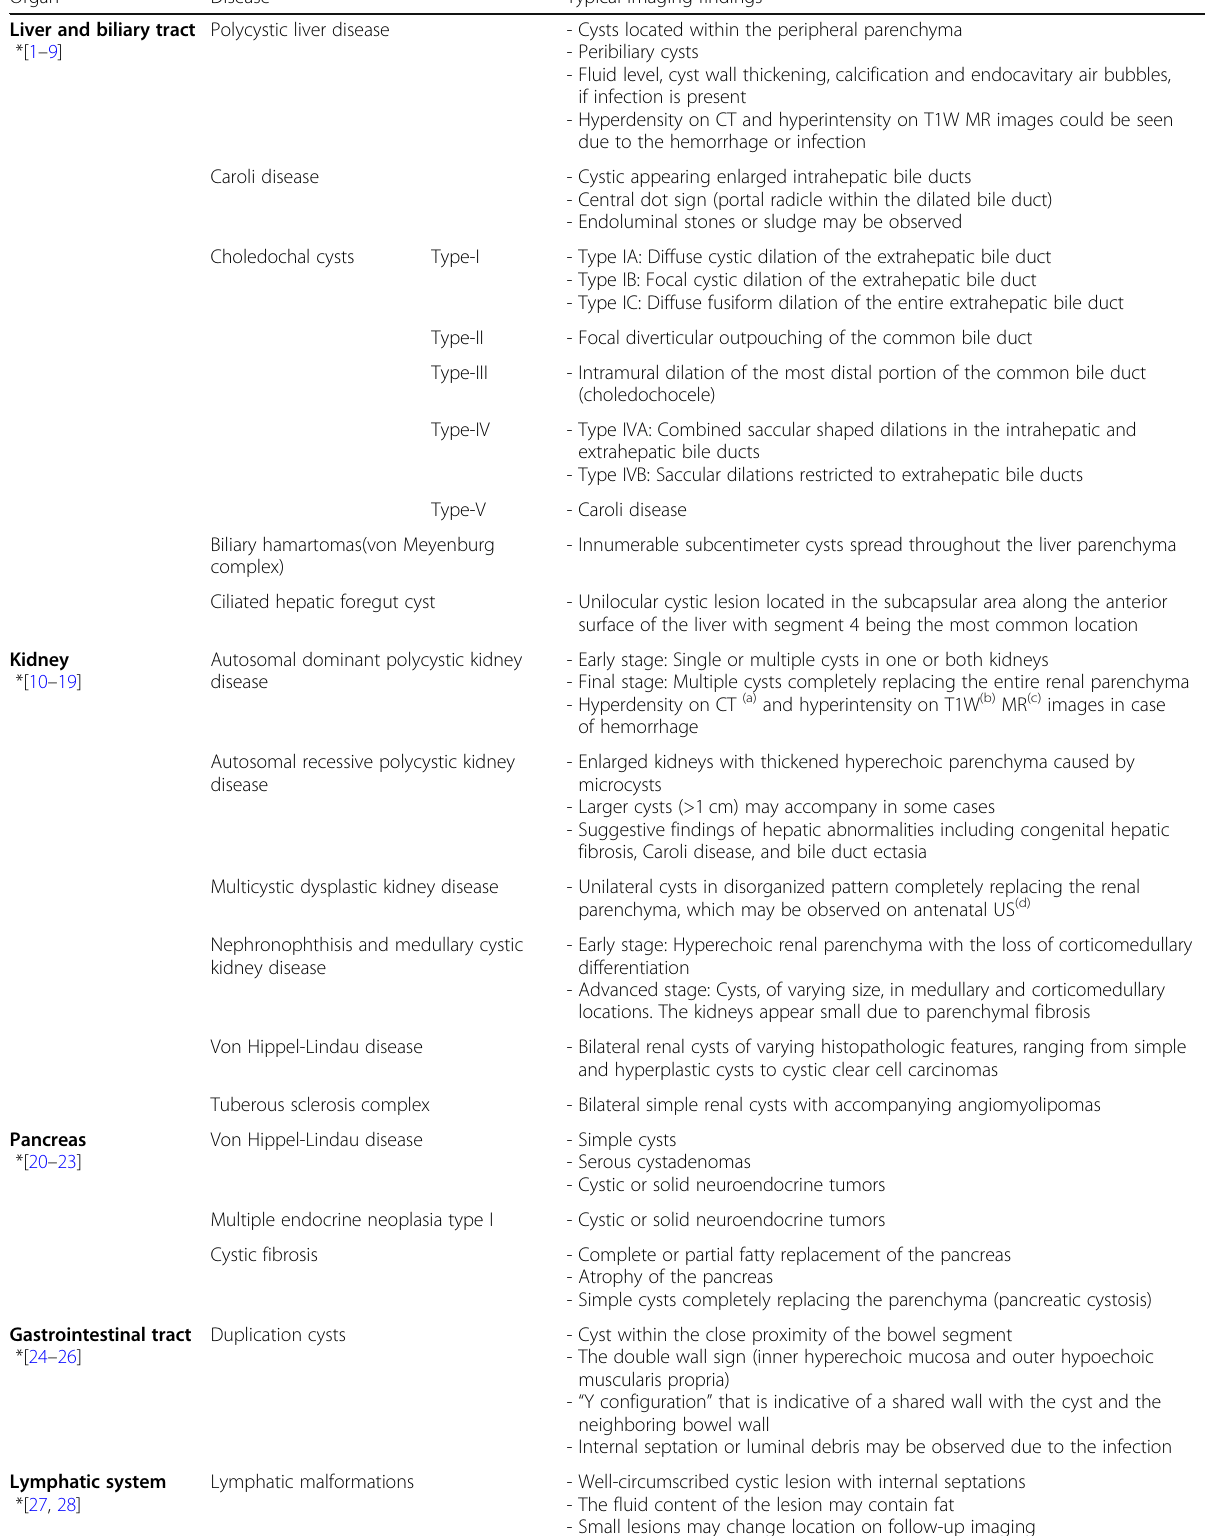
Table 1 Congenital and hereditary cystic diseases of the abdomen. Associated radiological